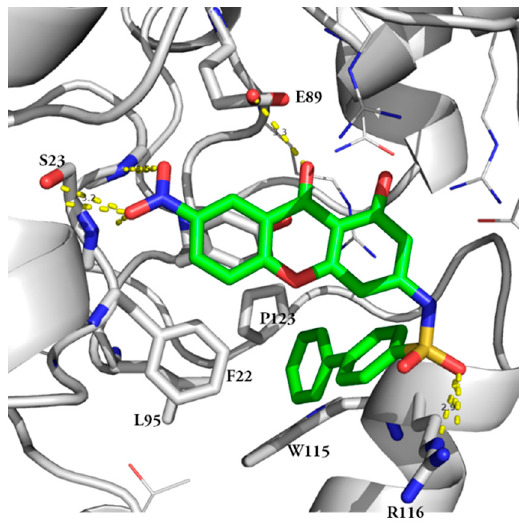
Figure 3. The docking model of 15h with PGAM1.